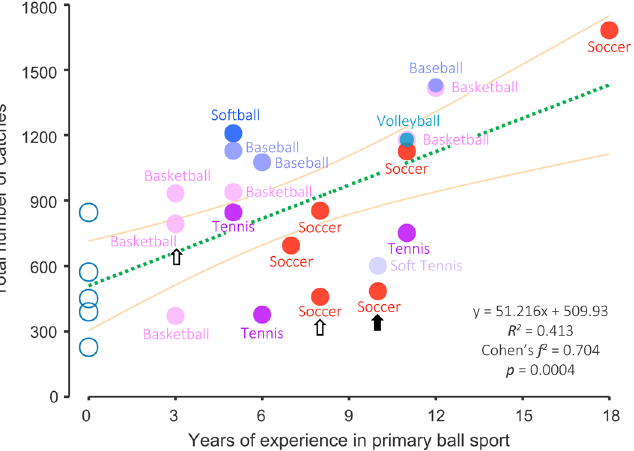
Figure 1. Relationship between years of experience in the primary ball sport and the total number of catches. Black and white arrows indicate the left- and mixed-handed participants, respectively. The overlaid plots can be displayed by resizing.